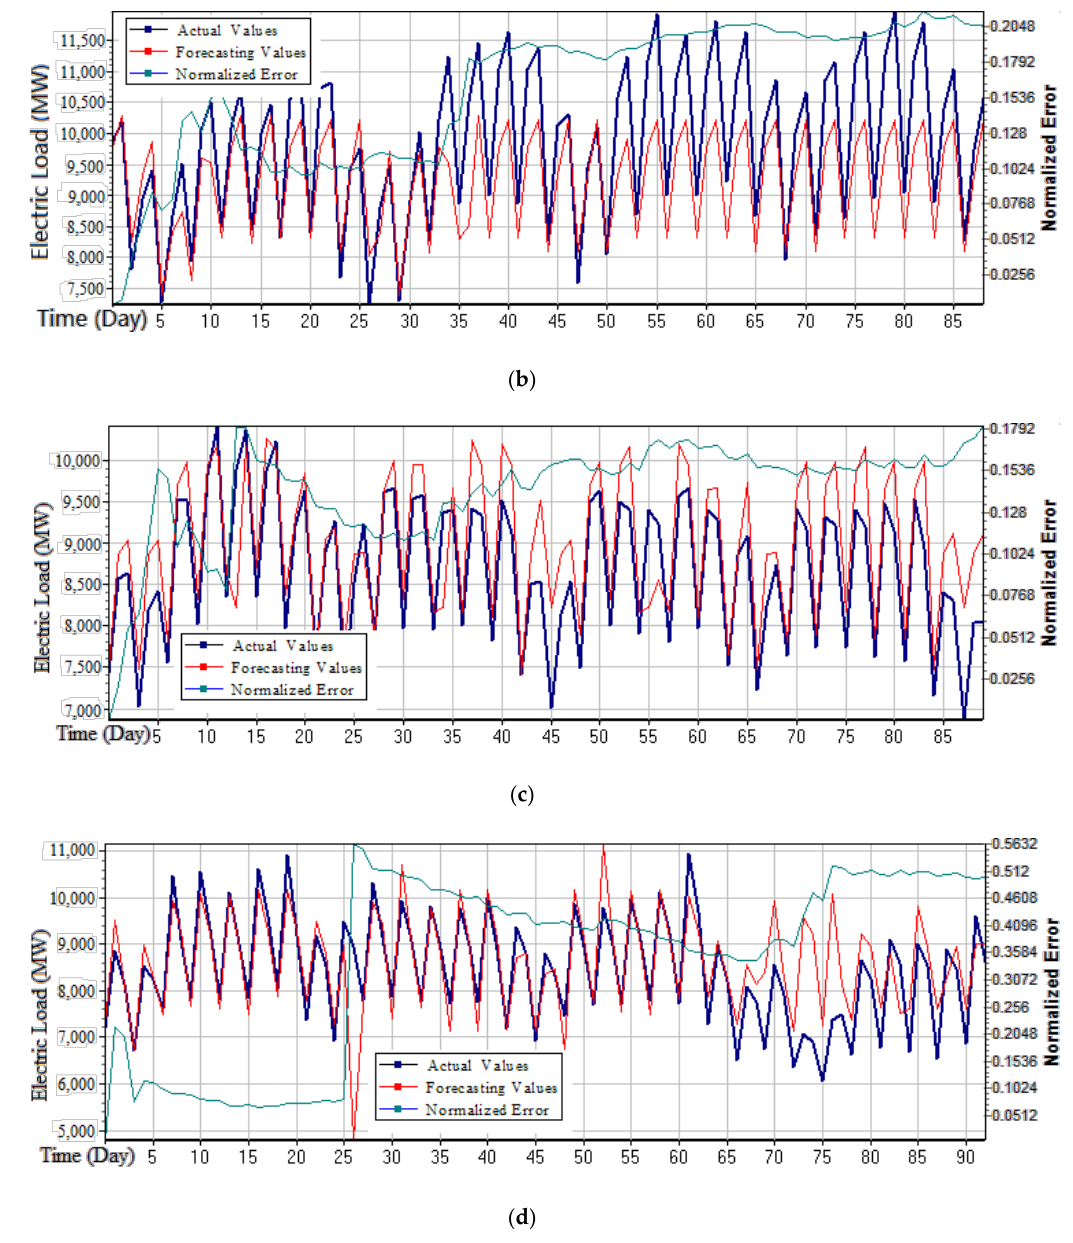
Figure 4. Forecasting results for large sample. ( a ) March, ( b ) June, ( c ) September, and ( d ) December.